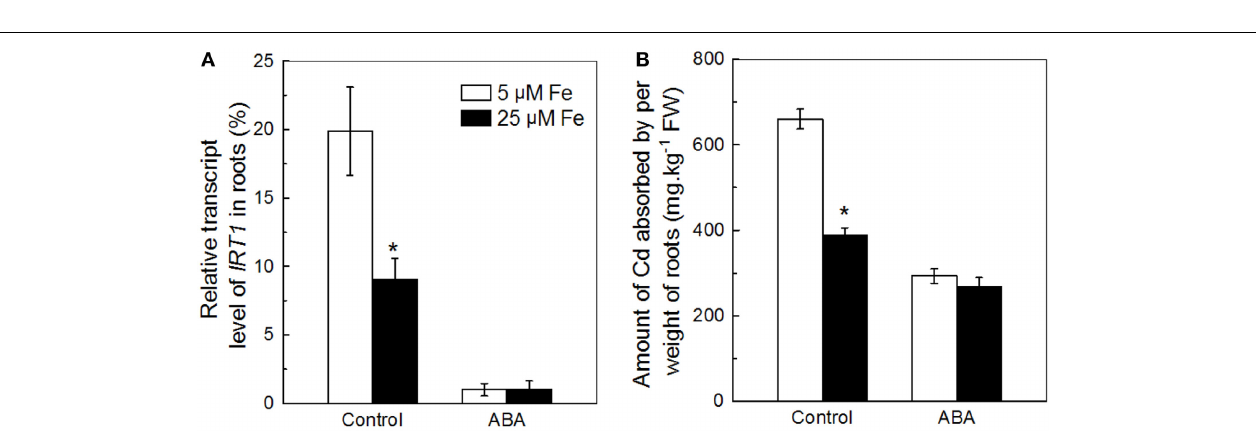
FIGURE 5 | Effects of ABA on (A) IRT1 expression and (B) Cd uptake in roots of Col-0 plants supplied with different levels of Fe. Plants were grown in 10 µ M Cd-added nutrient solution containing 0 or 0.5 µ M ABA. The Fe level in the nutrient solution was 25 or 5 µ M. The expression of